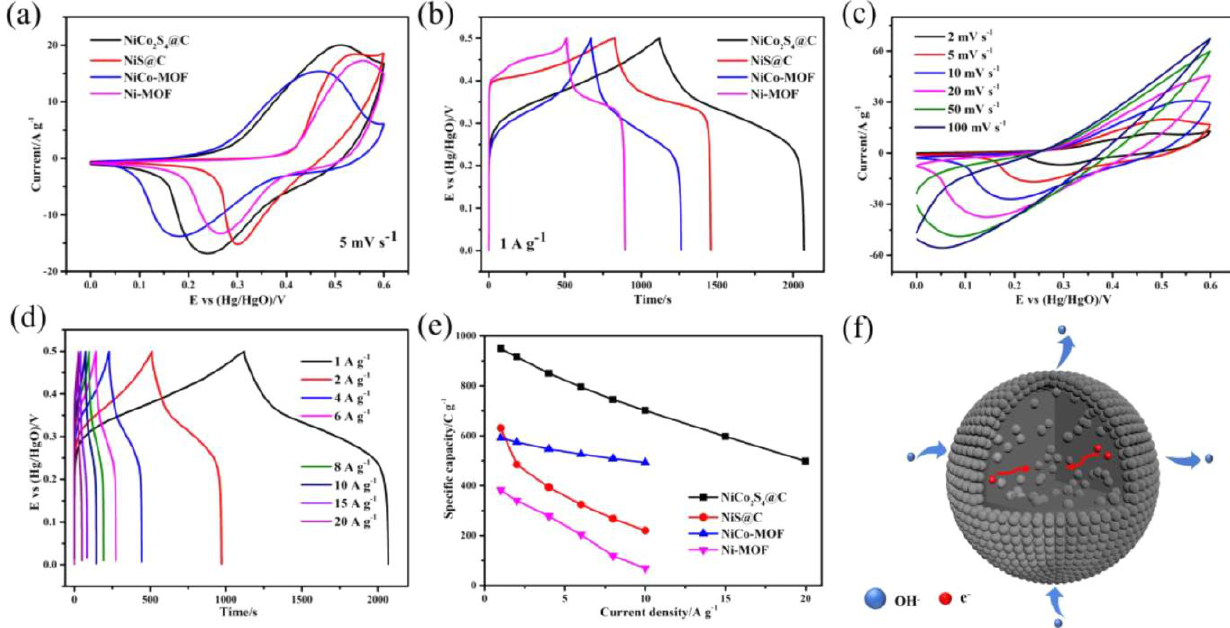
Figure 4. ( a ) CV and ( b ) GCD curves of NiCo 2 S 4 @C, NiS@C, NiCo-MOF, and Ni-MOF electrodes at a scan rate of 5 mV s −1 and a current density of 1 A g −1 , respectively. ( c ) CV curves of NiCo 2 S 4 @C electrode at scan rates from 2 to 100 mV s −1 , ( d ) GCD curves of NiCo 2 S 4 @C electrode at current densities from 1 to 20 A g −1 . ( e ) Specific capacity of NiCo 2 S 4 @C, NiS@C, NiCo-MOF and Ni-MOF electrodes measured at different current densities. ( f ) Schematic illustration of the sulfide microsphere composed of carbon-coated nanoparticles [47]. Copyright 2021 Elsevier.